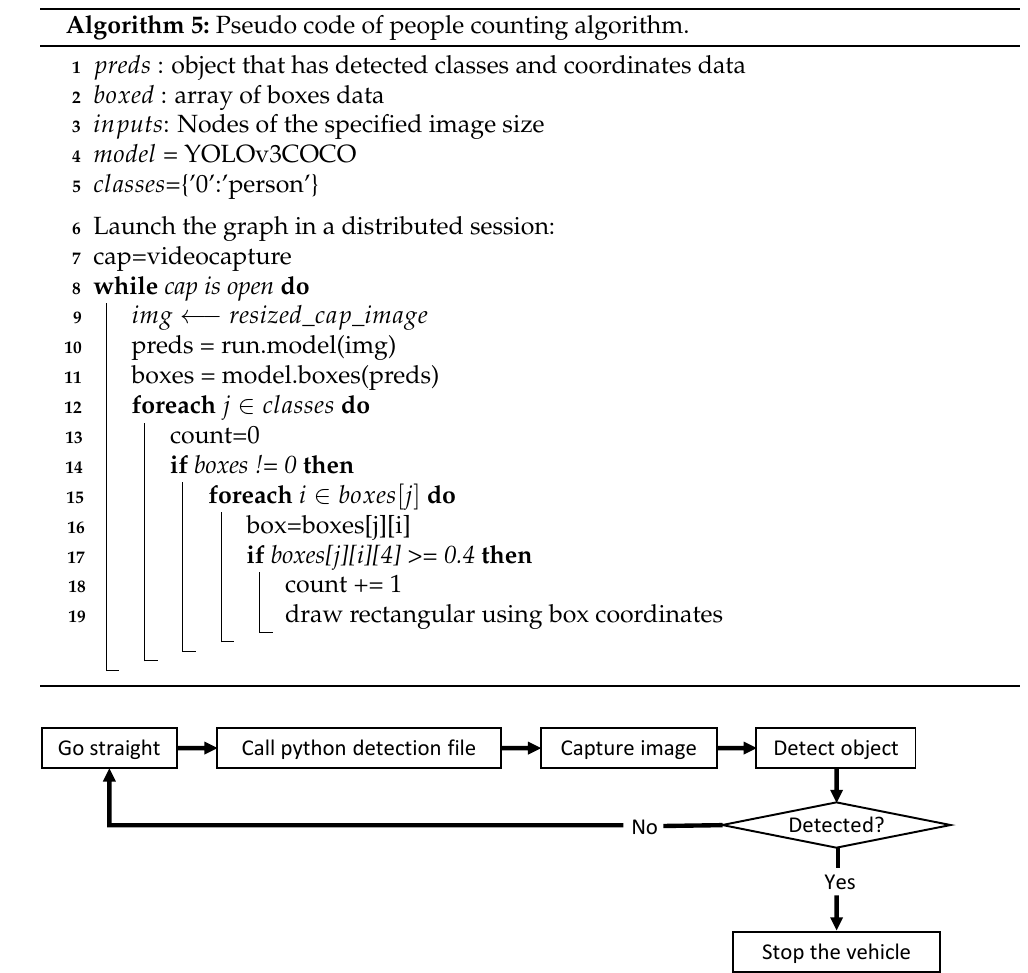
Algorithm 5: Pseudo code of people counting algorithm.